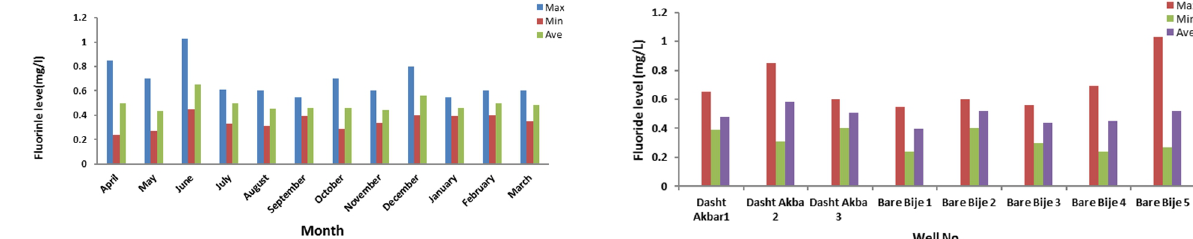
Fig.3 Average, maximum and minimum fluoride concentration(mg/l) of Dehloran drinking water sources in different months (a) and variety wells (b) in